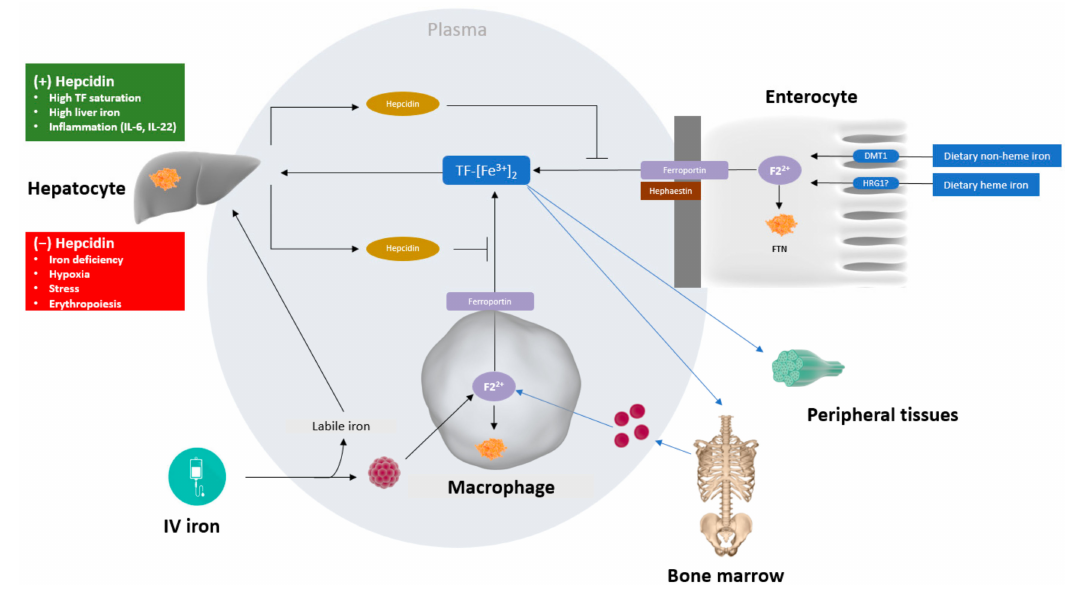
Figure 1. A simplified overview of iron metabolism. The major flow of iron in the body is via transferrin (TF), which transports iron from iron absorption in the enterocytes in the duodenum, the recycling of iron from senescent erythrocytes within macrophages of the reticuloendothelial system, and the mobilisation of iron storage within ferritin (FTN), that mainly resides within macrophages and hepatocytes. Iron export to plasma is mediated via the sole iron exporter, ferroportin and is controlled by its ligand, hepcidin, which is secreted into blood plasma mainly by hepatocytes. Hepcidin binds to ferroportin and controls ferroportin concentration through promoting its endocytosis. Almost all plasma iron is bound to TF, but after infusion of iron supplements, labile (unbound) iron may appear in plasma. The molecular structure of third generation IV irons confers stability on the iron complex, with the intention of limiting the amount of labile iron entering the plasma after infusion and ensuring a controlled release of iron from the complex once taken up by macrophages. How the different IV iron complexes are handled in the macrophage and the basis for their different solubility is not well characterised, but will be dependent not only on pH, but the low molecular weight molecules that are present in the lysosome and their different iron-binding affinities and on macrophage polarisation/differentiation. Iron released from the iron–carbohydrate complex is either stored as ferritin or transported out of the macrophage and bound to